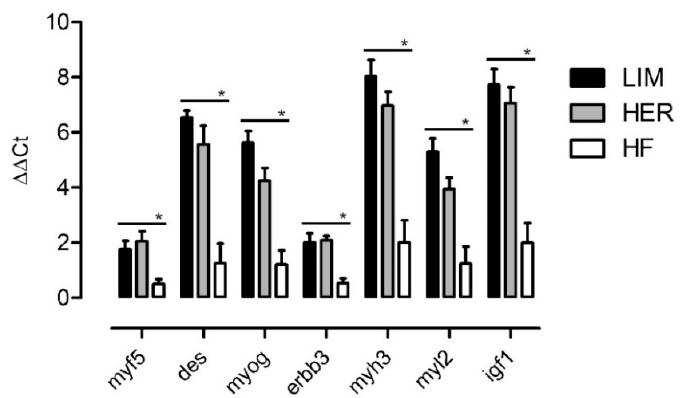
Figure 4. qPCR verification of selected genes associated with muscle organ development. The obtained results were statistically elaborated using one-way analysis of variance and Tukey’s multiple range test. Results are presented as mean ± standard error and are marked with asterisk * for p < 0.05; n = 4 for each breed; gapdh —reference gene; GraphPad Prism 5 (GraphPad Software Inc.,